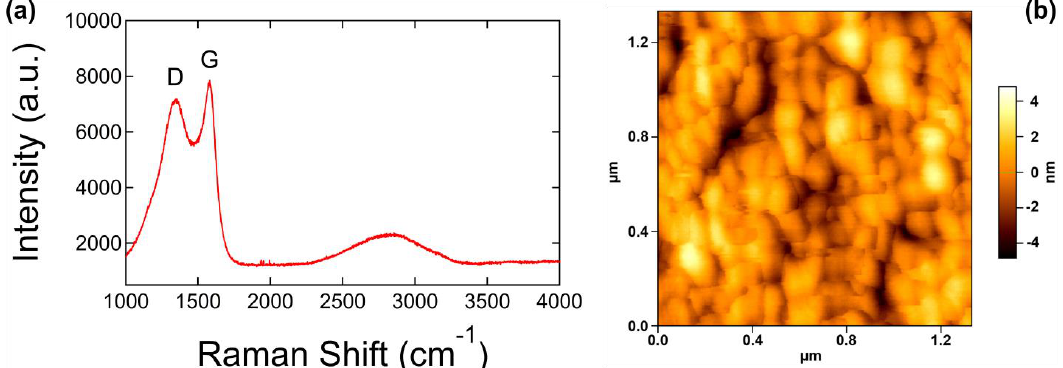
Figure 3. ( a ) Raman spectrum of GUITAR on a silicon substrate obtained with a 532 nm excitation source and ( b ) an AFM image of GUITAR on a silicon substrate showing GUITAR’s surface morphology, which is comprised of an agglomeration of carbon spheroids ~50 nm in diameter.